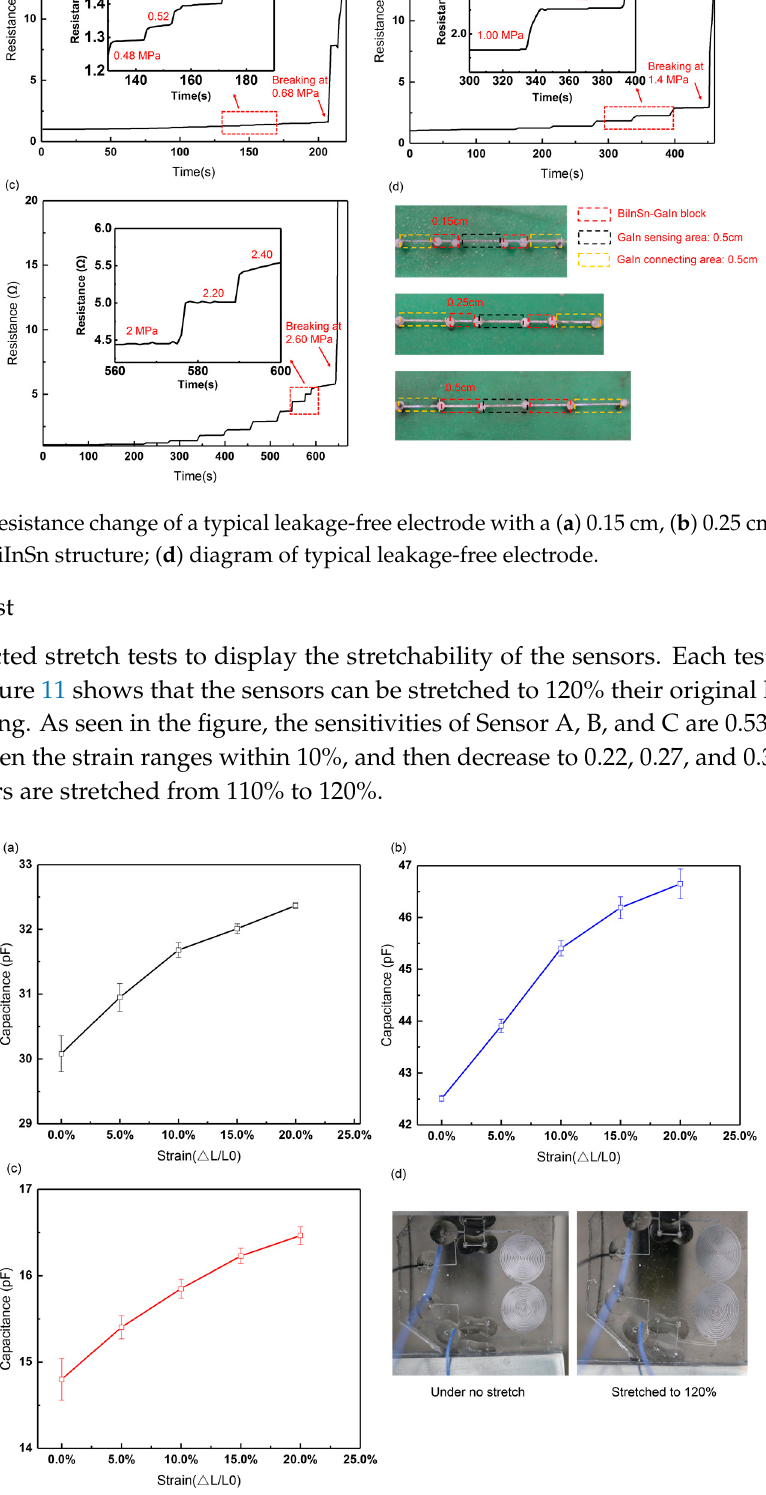
Figure 9. Capacitance change of leakage-free electrode-based ( a ) Sensor A, ( b ) Sensor B, and ( c ) Sensor C under increasing pressure from 0 to 1.48 MPa; ( d ) electrode failure of the stretchable sensors.